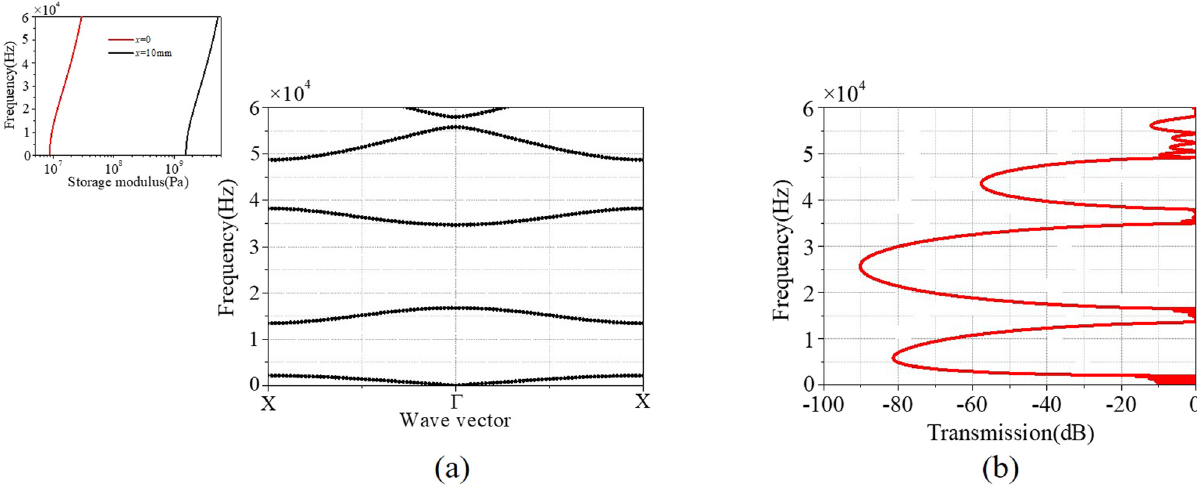
Figure 3: Band gaps of a normal incident SH - wave characterized by ( a ) dispersion curves and ( b ) transmission